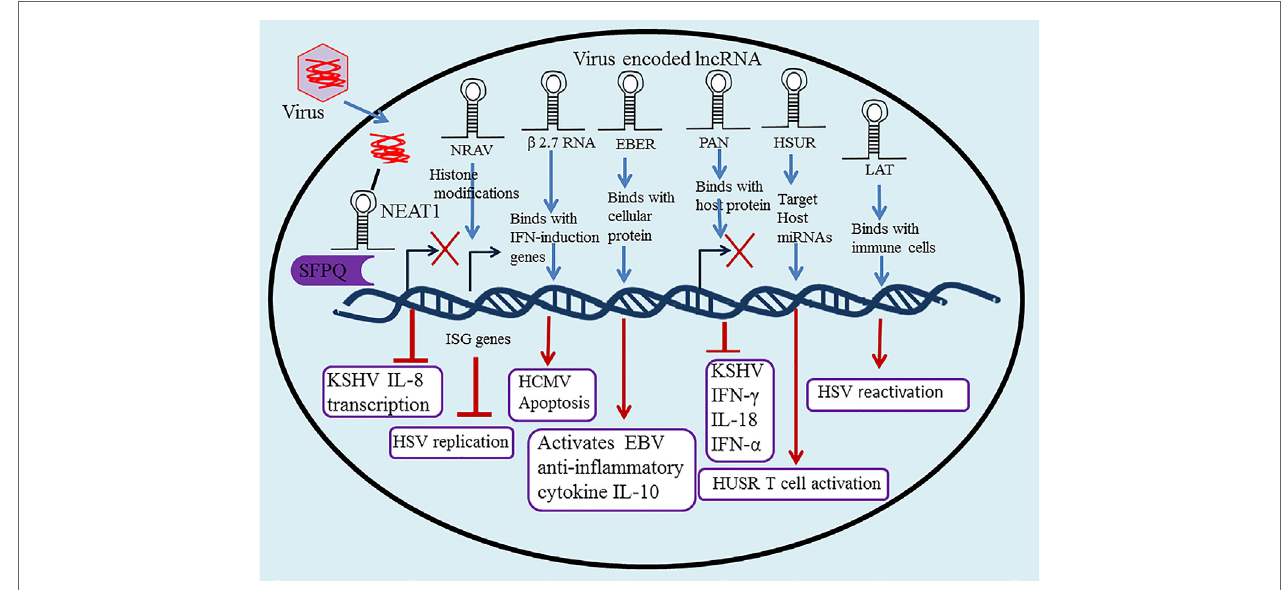
FigURe 2 | Long non-coding RNA (lncRNA) in regulation of the innate and adaptive immune system upon herpesvirus infection. Many lncRNAs have been associated with regulation of the innate and adaptive immune response and host–pathogen interactions, including nuclear paraspeckle assembly transcript 1 (NEAT1), negative regulator of antiviral (NRAV), polyadenylated nuclear (PAN), Epstein–Barr virus-encoded non-coding RNAs (EBERs), herpesvirus saimiri U-rich RNAs (HSURs), β 2.7 RNA, and latency-associated transcript